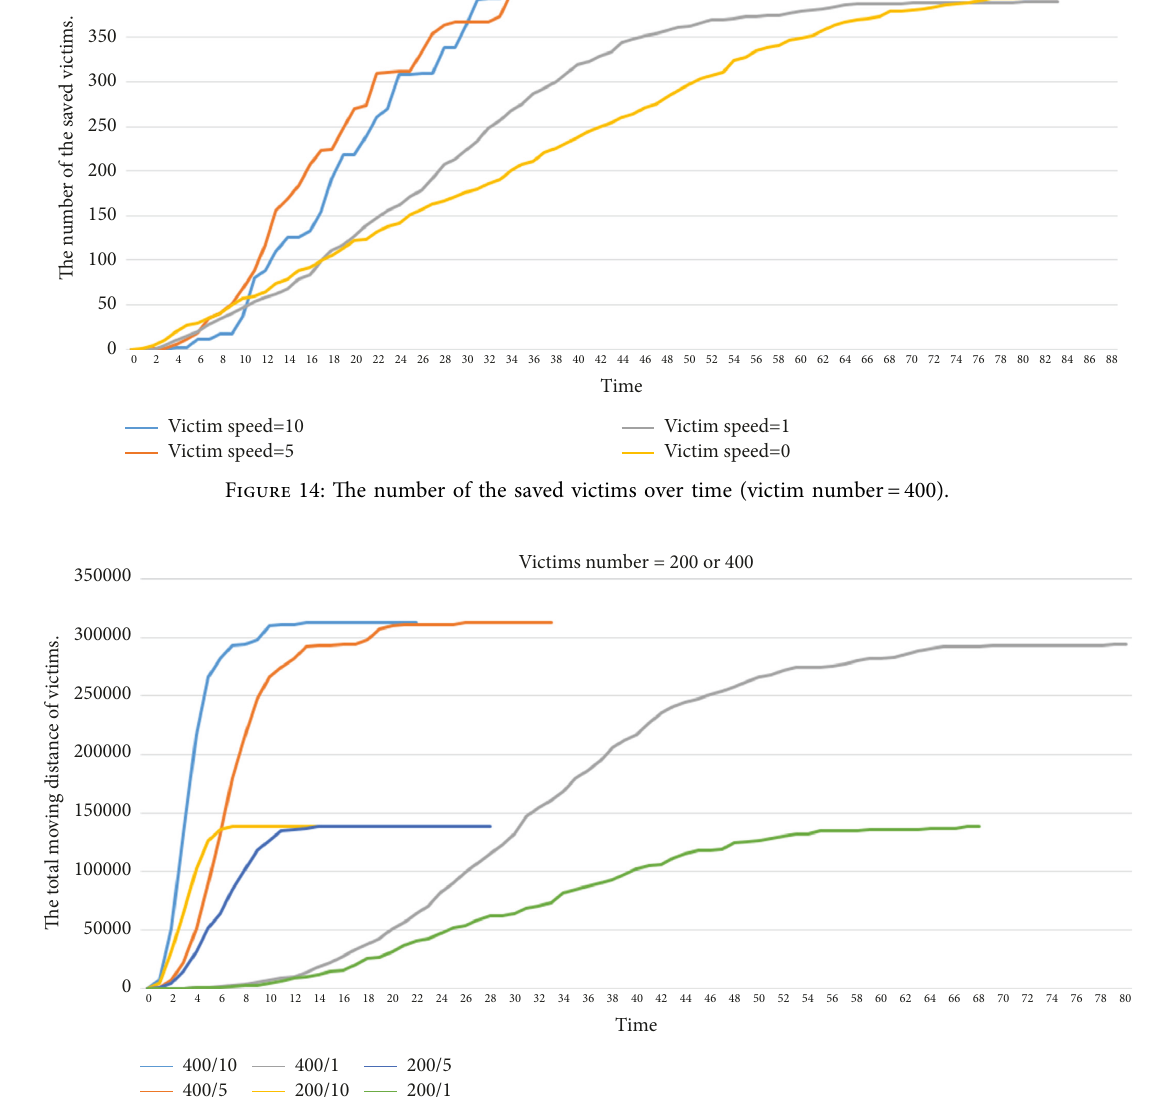
Figure 15: The total distance of all the victims over